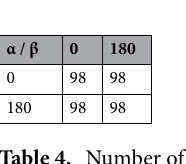
Table 4. Number of slices in U-shape.